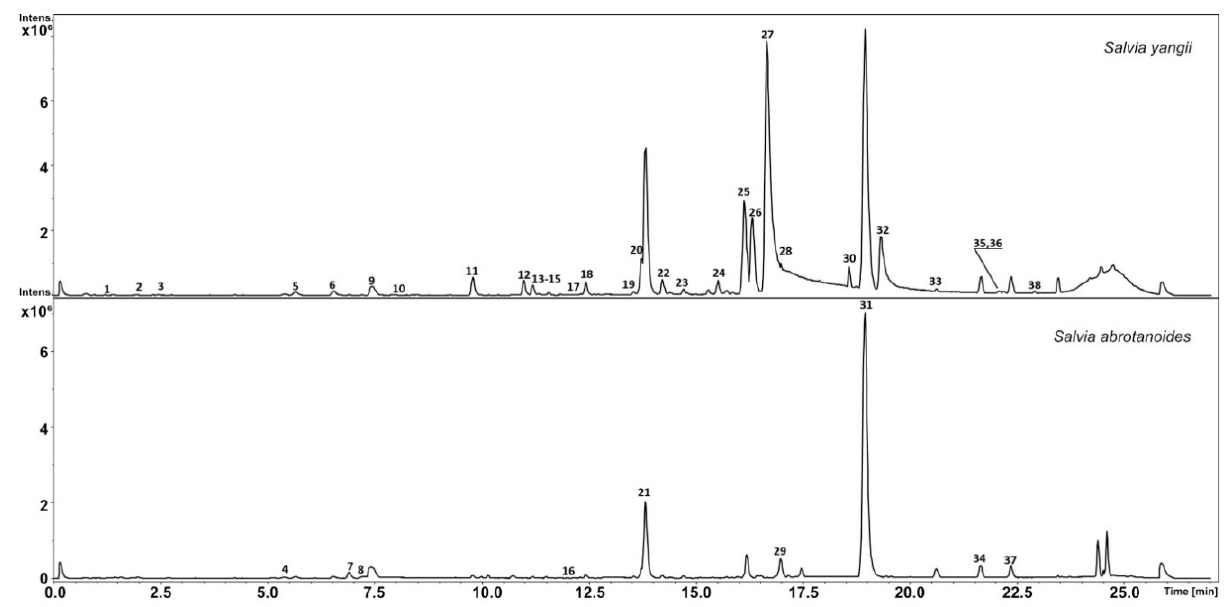
Figure 2. BPC chromatogram of the main metabolites identified in the MeOH extract of roots of S. yangii and S. abrotanoides , harvested in the middle of the